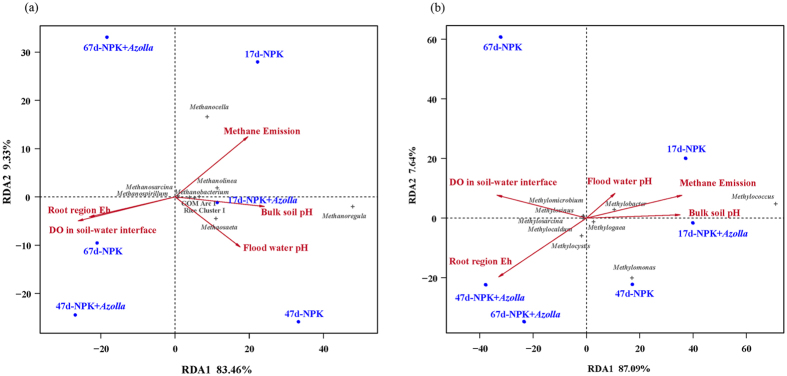
Redundancy analysis (RDA) displaying the relationship among environmental parameters (red), paddy soil samples (blue) and relative abundances (gray) of methanogenic archaeal (a) and methanotrophic bacterial (b) communities classified at the genus level. Only the genera known to be methanogens (a) and methanotrophs (b) are shown on the RDA plot. NPK, rice cropping without dual cropping of Azolla under recommended fertilization; NPK + Azolla, rice cropping with dual cropping of Azolla under recommended fertilization.